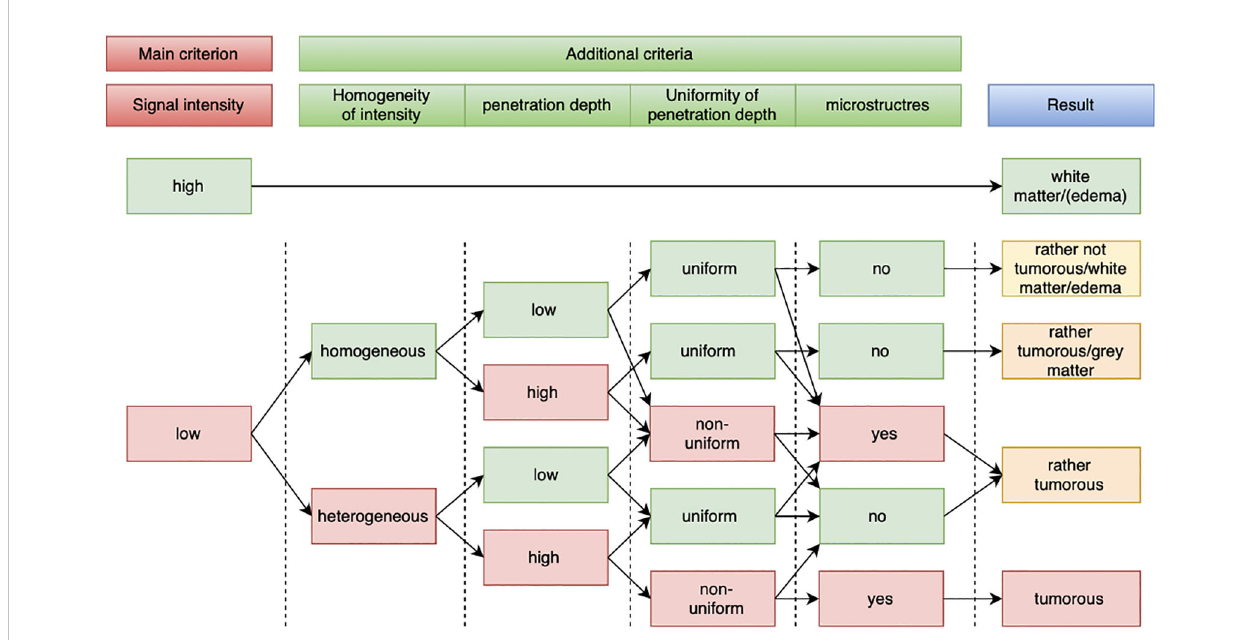
FIGURE 2 Flowchart for visual classi fi er. OCT signal intensity was set as main criterion. Homogeneity of signal, penetration depth, uniformity of penetration depth and the appearance of micro structures were set as additional criteria. Image properties that indicate healthy tissue are highlighted in green rectangles; image properties that indicate tumorous tissue are highlighted in red